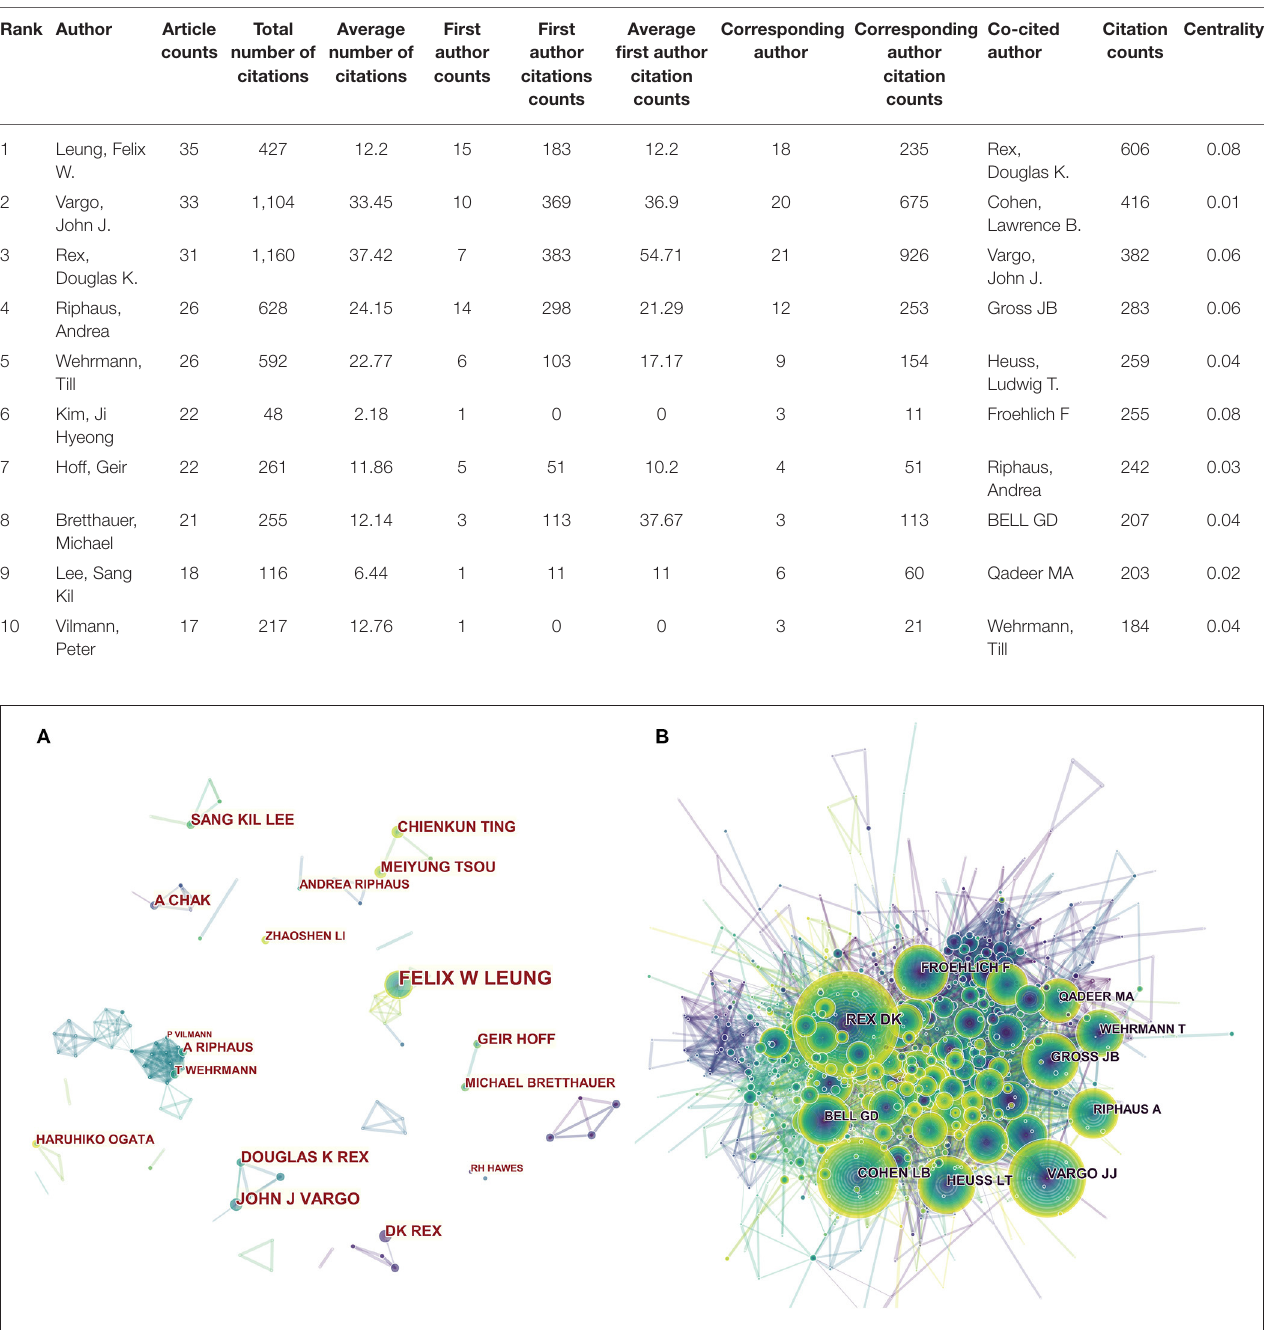
the most salient network structure. Visualization of co-cited references showed 1,145 nodes and 2,637 links. In this network, each node represents a cited article, and the size of each node is proportional to the total frequency of co-citation of the associated article. As shown in Figure 7A , the co-cited